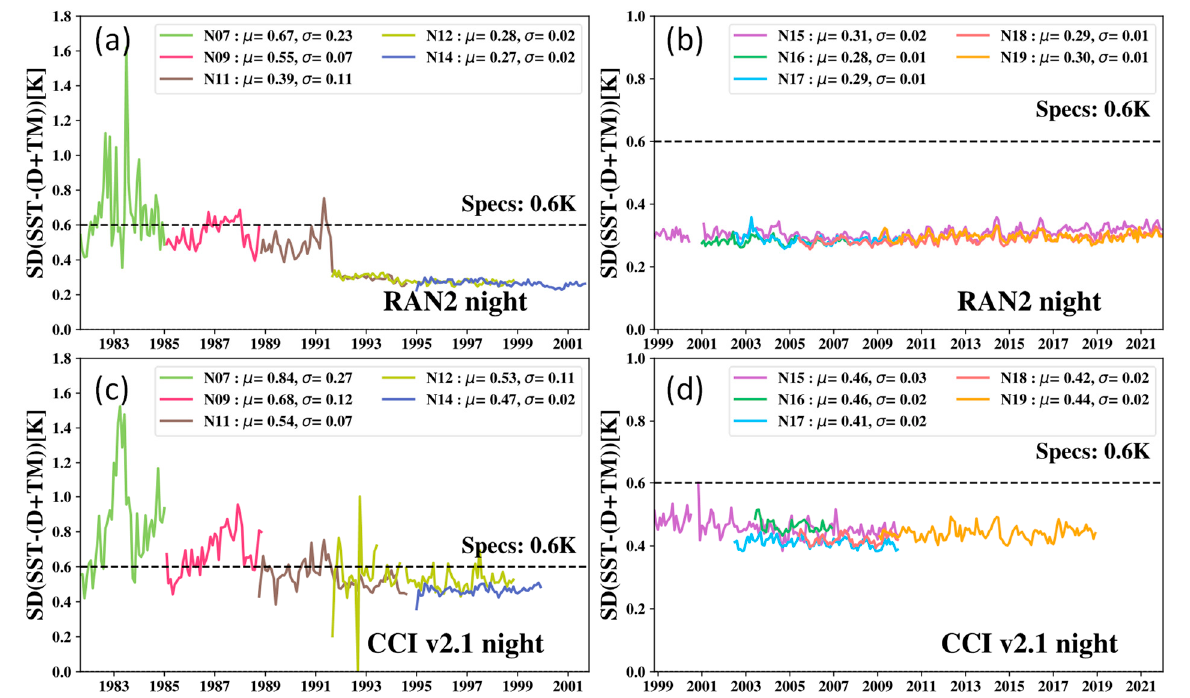
Figure 17. Global monthly nighttime SDs with respect to (D + TM) for ( a , b ) RAN2 ‘depth’ SST and ( c , d ) CCI ( a , c ) AVHRR/2s; ( b , d ) AVHRR/3s. (Data are from the NOAA SQUAM system [21,22].)